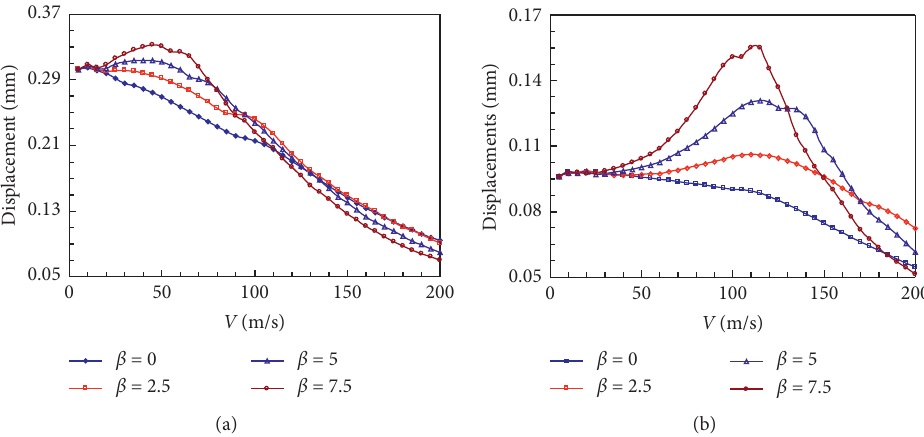
Figure 11: The maximum displacements of the track with various elastic stiffness: (a) k � 138.6 × 10 6 N/m 2 and (b) k � 500 × 10 6 N/m 2